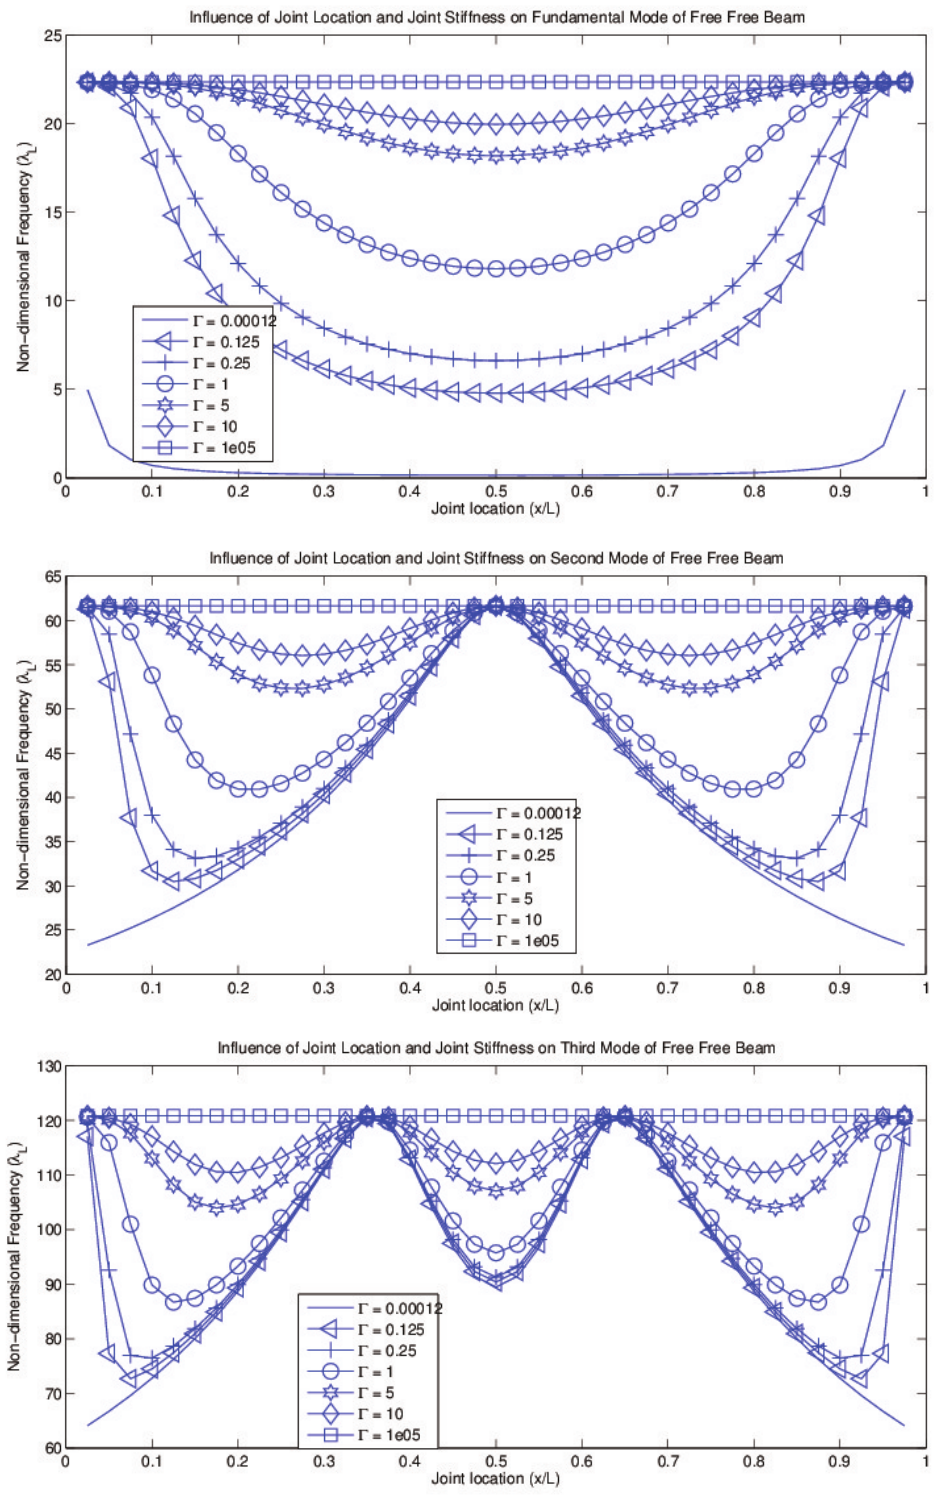
Fig. 2. Influence of joint location as well as joint stiffness on first three (Mode1, Mode2 and Mode3) vibration modes of uniform free-free